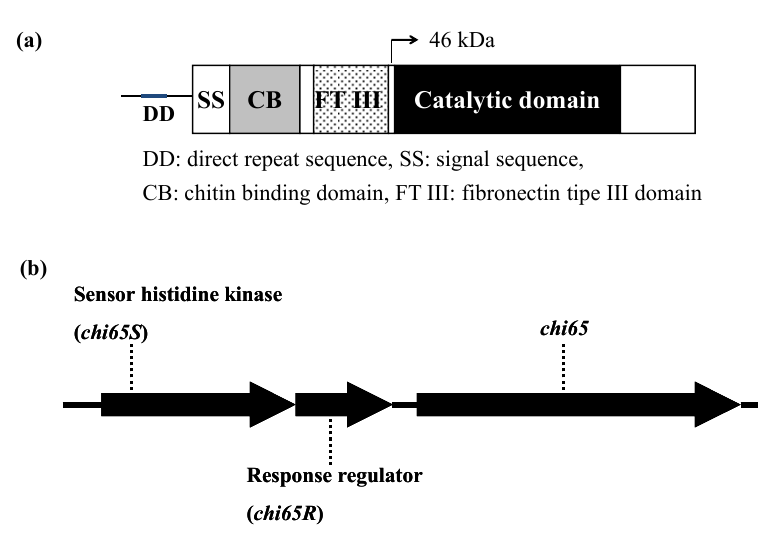
Figure 4. Schematic representation of chi65 ( a ), chi65R and chi65S ( b